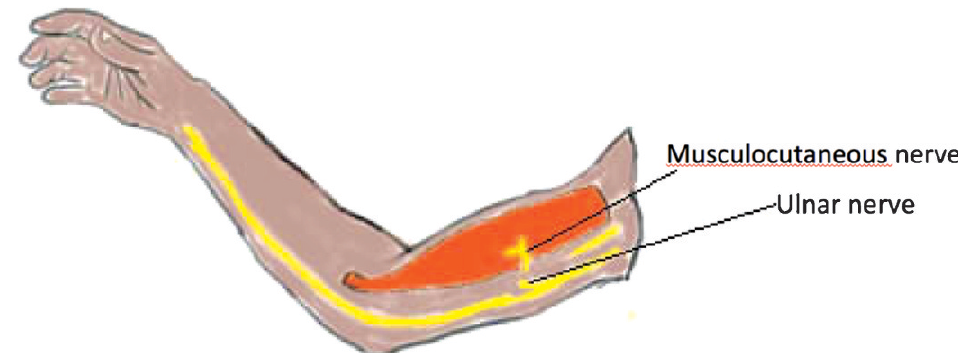
Figure 2 - Ulnar nerve to musculocutaneous nerve (Oberlin procedure).